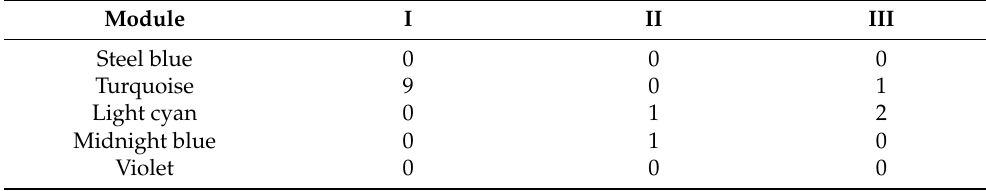
Figure 5. Co-expression network analysis for the construction of modules at three stages of SYQ. ( A ) Clustering dendrogram of SYQ root unigenes with assigned module colors. Genes clustering analysis based on TOM-based dissimilarity. Module divided by dynamic tree cut; different colors represented different modules. ( B ) Relationships between module eigengenes (ME) and traits at three stages. Each row corresponds to a module, and each column corresponds to a trait. Colors indicate the strength and direction of the correlation according to the color legend at right. The number in parentheses is the partial Pearson correlations and the corresponding p -values. Table 2. Distribution of DEGs related to (I) starch and sucrose metabolism, (II) flavonoid and phenyl- propanoid biosynthesis, and (III) plant hormone signal transduction pathways in the five modules which were significantly correlated with the content of metabolite.